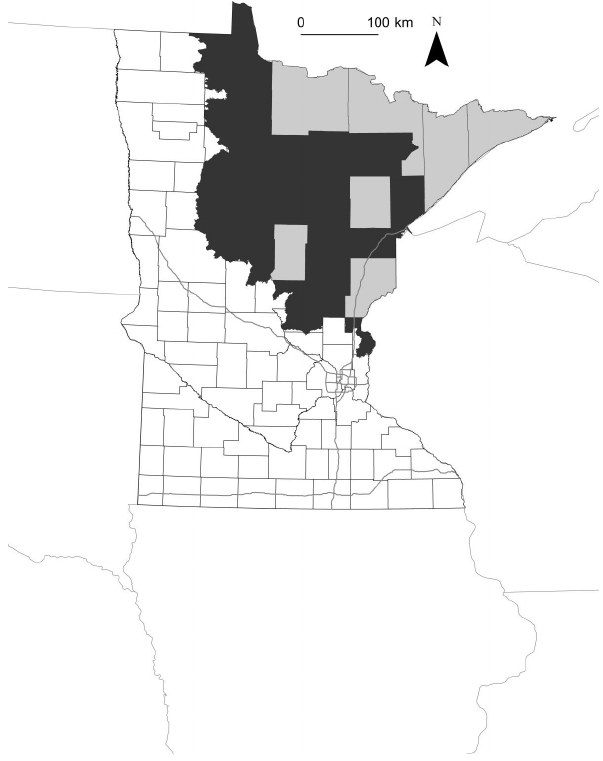
Figure 1. Study area (shaded black; contains soils surveys) in Min- nesota’s Laurentian Mixed Forest (shaded black and